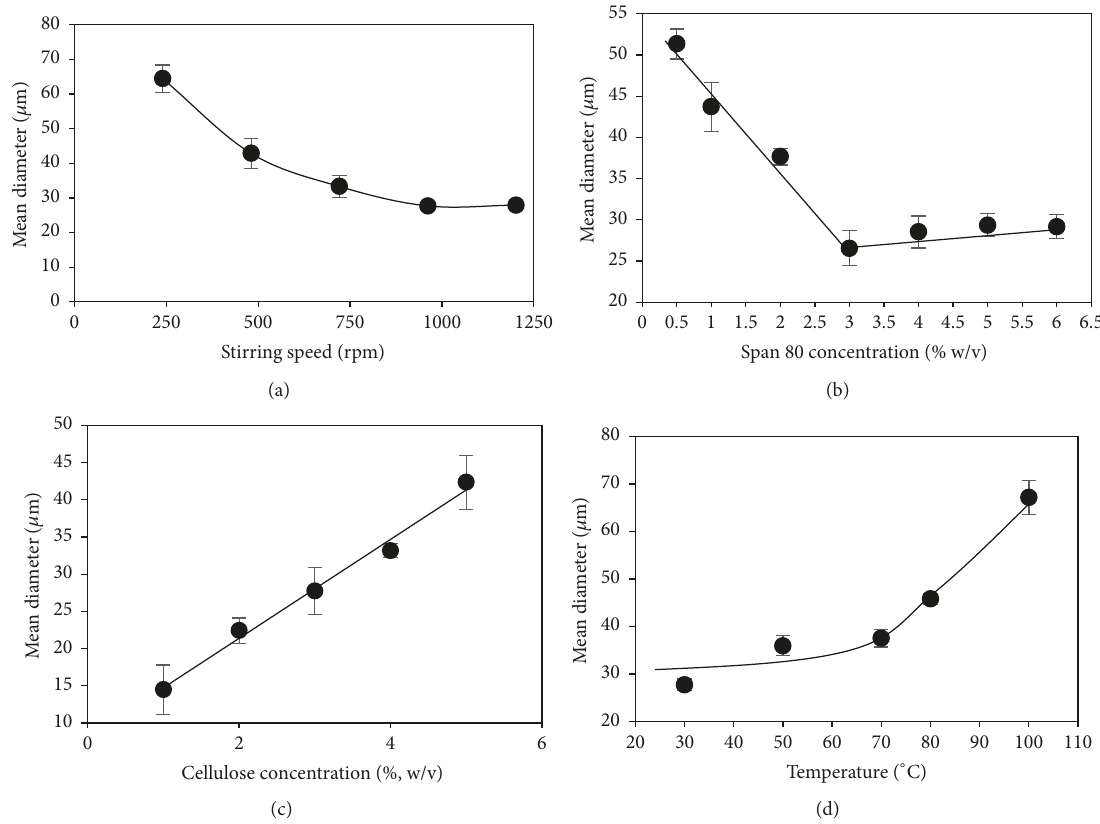
Figure 2: Effect of fabrication parameters on the mean diameter of 𝜇 CBs, (a) stirring speed (250–1250 rpm), (b) surfactant (Span 80) concentration (0.5–6.0% w/v), (c) cellulose concentration (1–5% w/v), and (d) reaction temperature (30–100 ∘ C). Note: other synthesis parameters were being fixed as applicable (3% w/v cellulose solution; 2% w/v Span 80; stirring speed 1000 rpm; 30 ∘